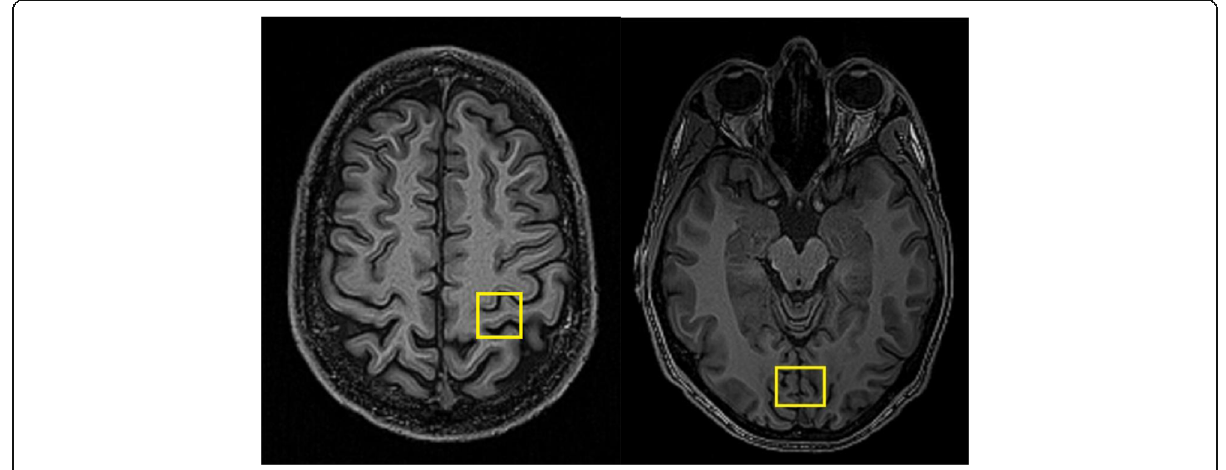
Fig. 1 Example SPECIAL MRS voxel placement in the primary somatosensory cortex (left) and the occipital cortex